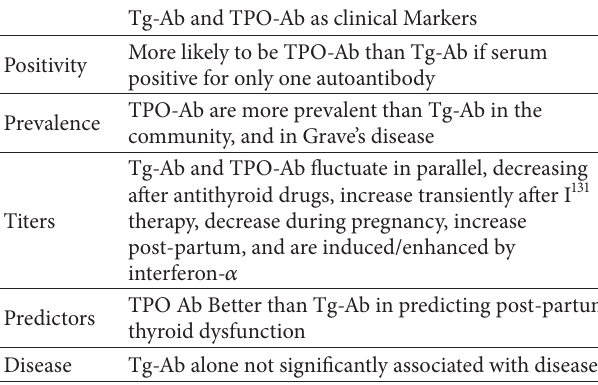
Table 1: Tg-Ab and TPO-Ab as clinical